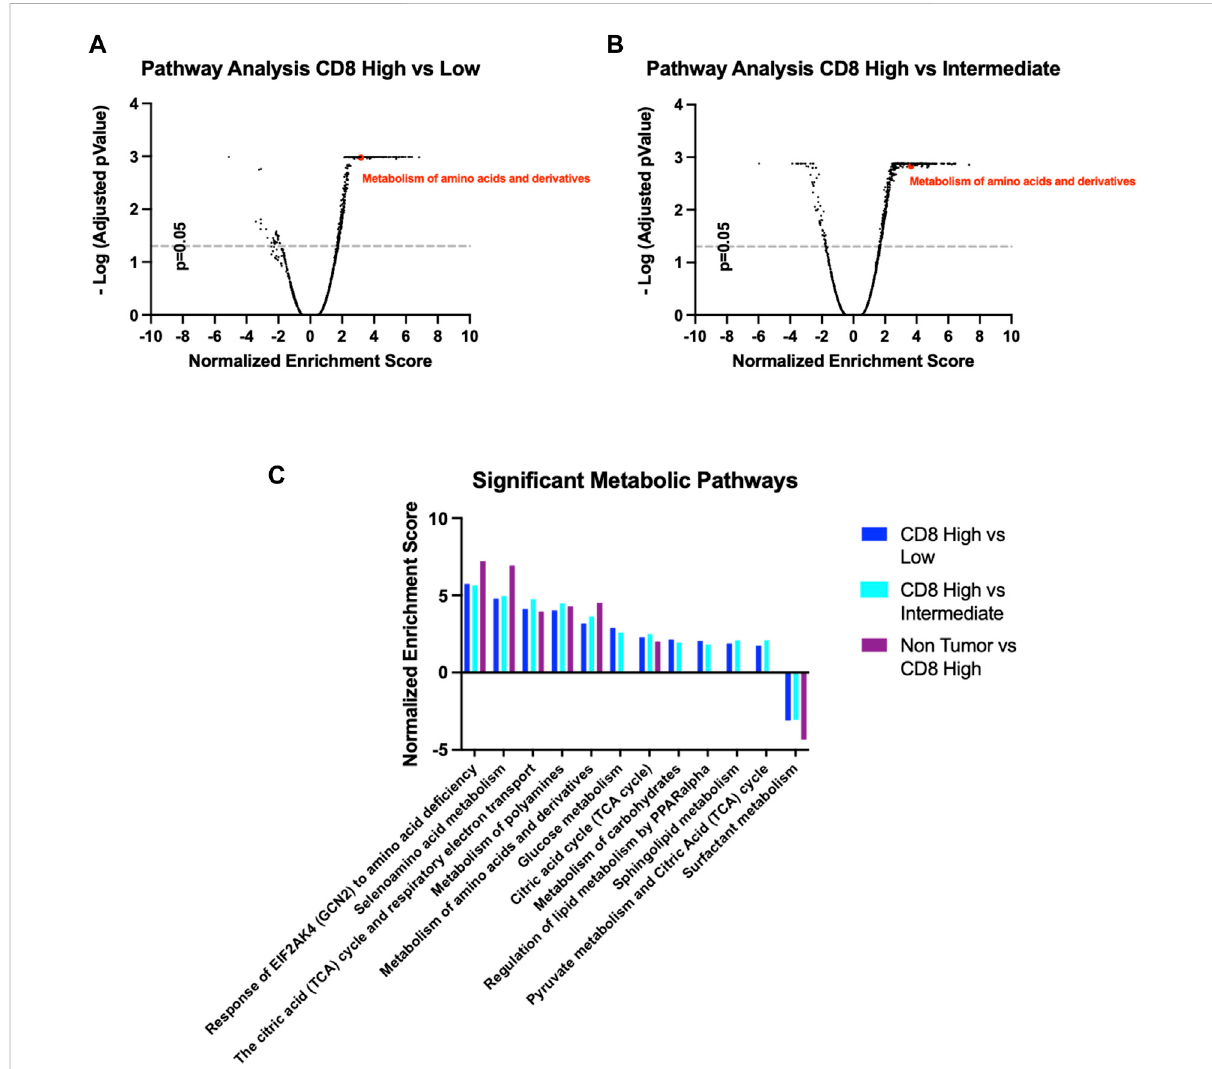
FIGURE 7 (A,B) Volcanoplotsfor pathwayenrichmentintheReactomePathwayDatabasecomparingCD8highwitheitherCD8intermediateorCD8low ROIs. (C) Signi fi cant metabolic pathways follow similar pattern according to their CD8 in fi ltration, CD8 high ROIs being the most similar to the non- tumoral